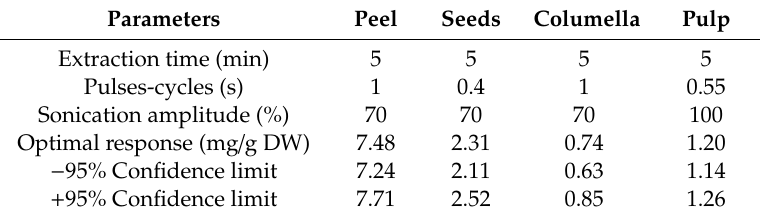
Table 4. Optimal conditions of ultrasound-assisted extraction in total alkaloids from A . muricata peel, seed, columella, and pulp. Parameters Peel Seeds Columella Pulp Extraction time (min) 5 5 5 5 Pulses-cycles (s) 1 0.4 1 0.55 Sonication amplitude (%) 70 70